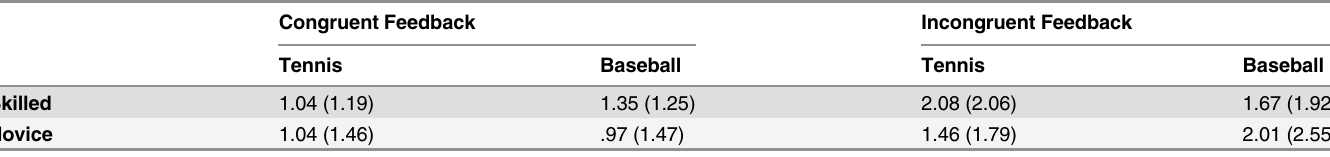
Table 2. Percentages of Error